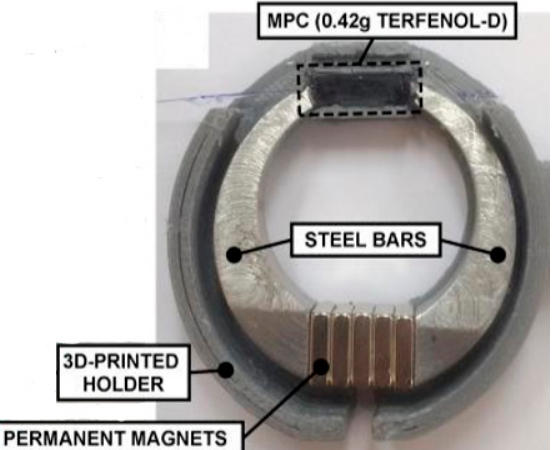
Figure 13. Optical fiber current sensor based on 0.42 g cuboid magnetostrictive composite material. Table 1. Comparison: FBG-based current sensorsfor high-voltage lines.